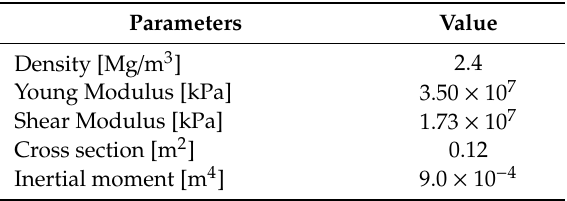
Table 3. Elastic beam column element parameters.